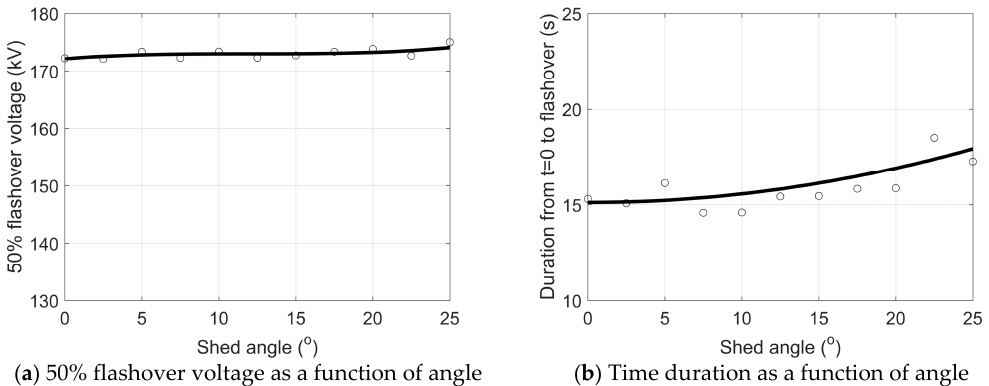
Figure 16. 50% flashover voltage and time duration as functions of the shed angle.